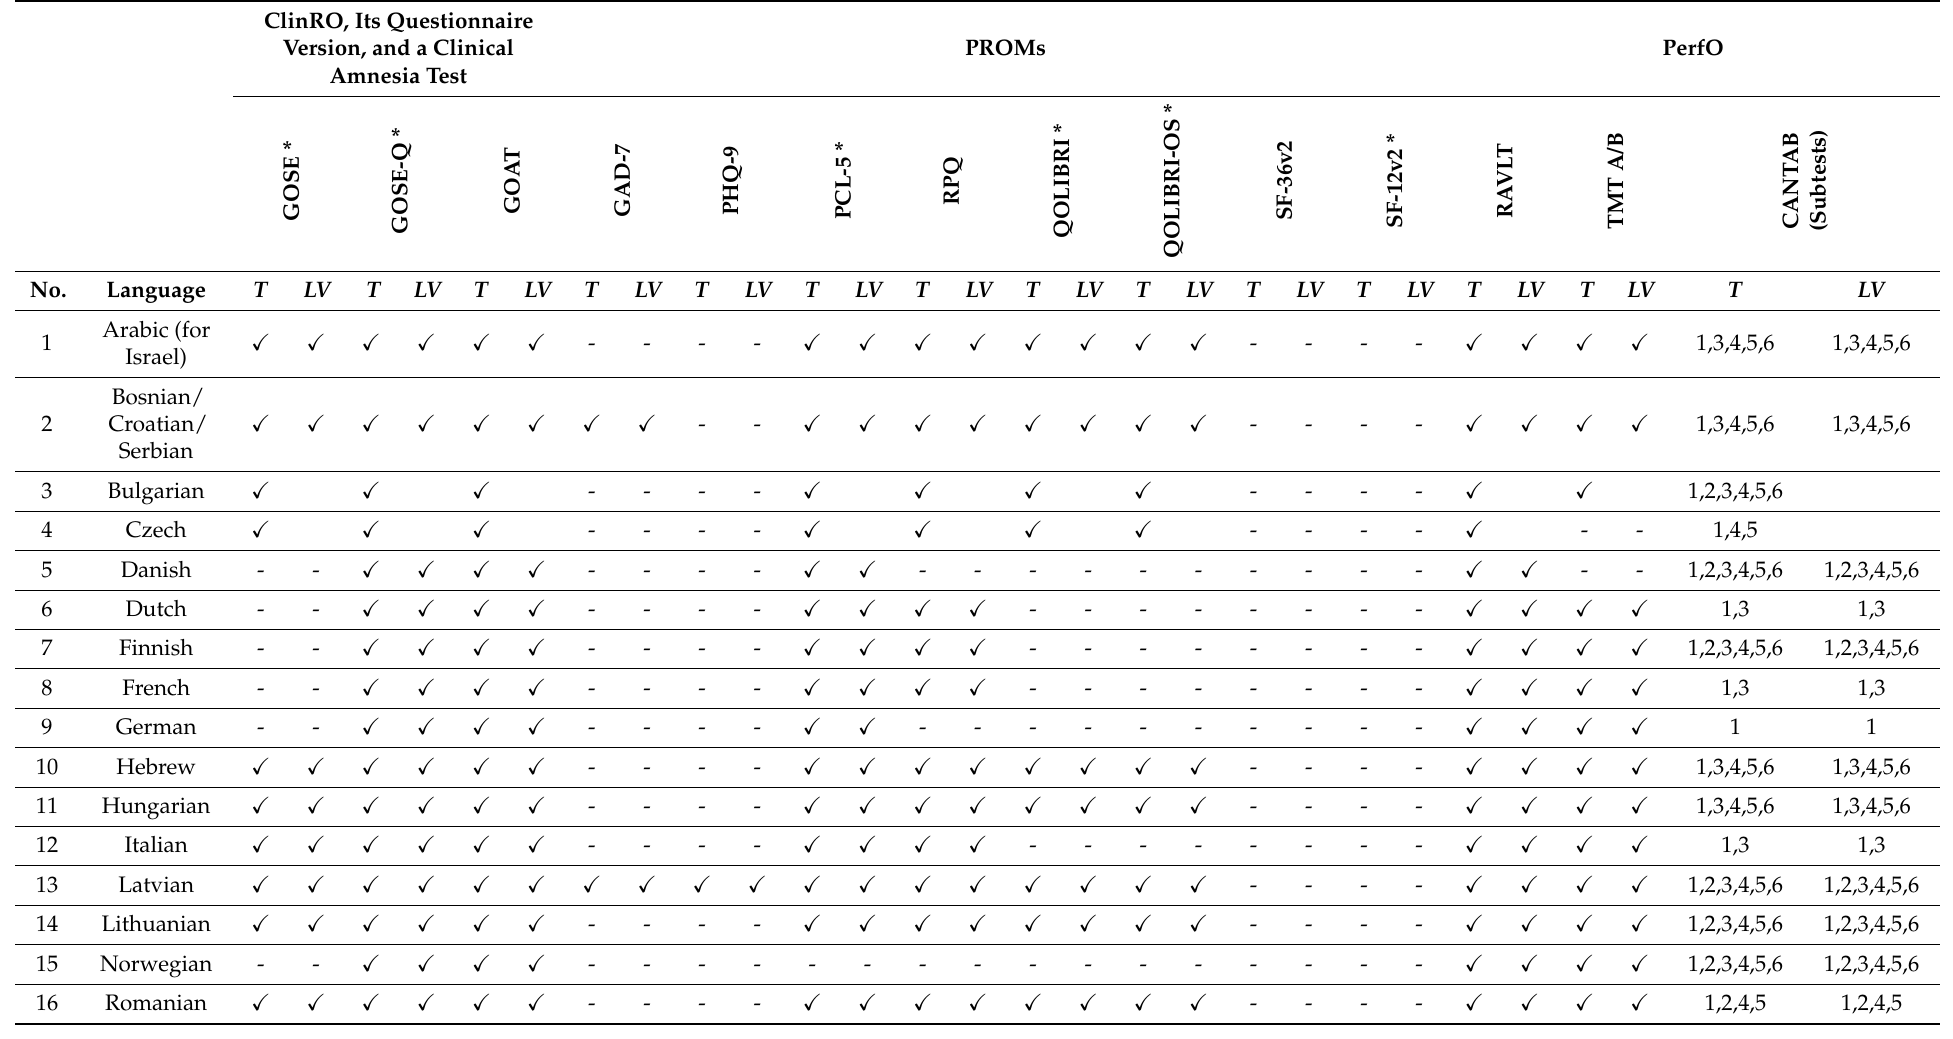
Table 3. Pre-existing translations and translated and linguistically validated versions in the target languages of the participating countries. ClinRO, Its Questionnaire Version, and a